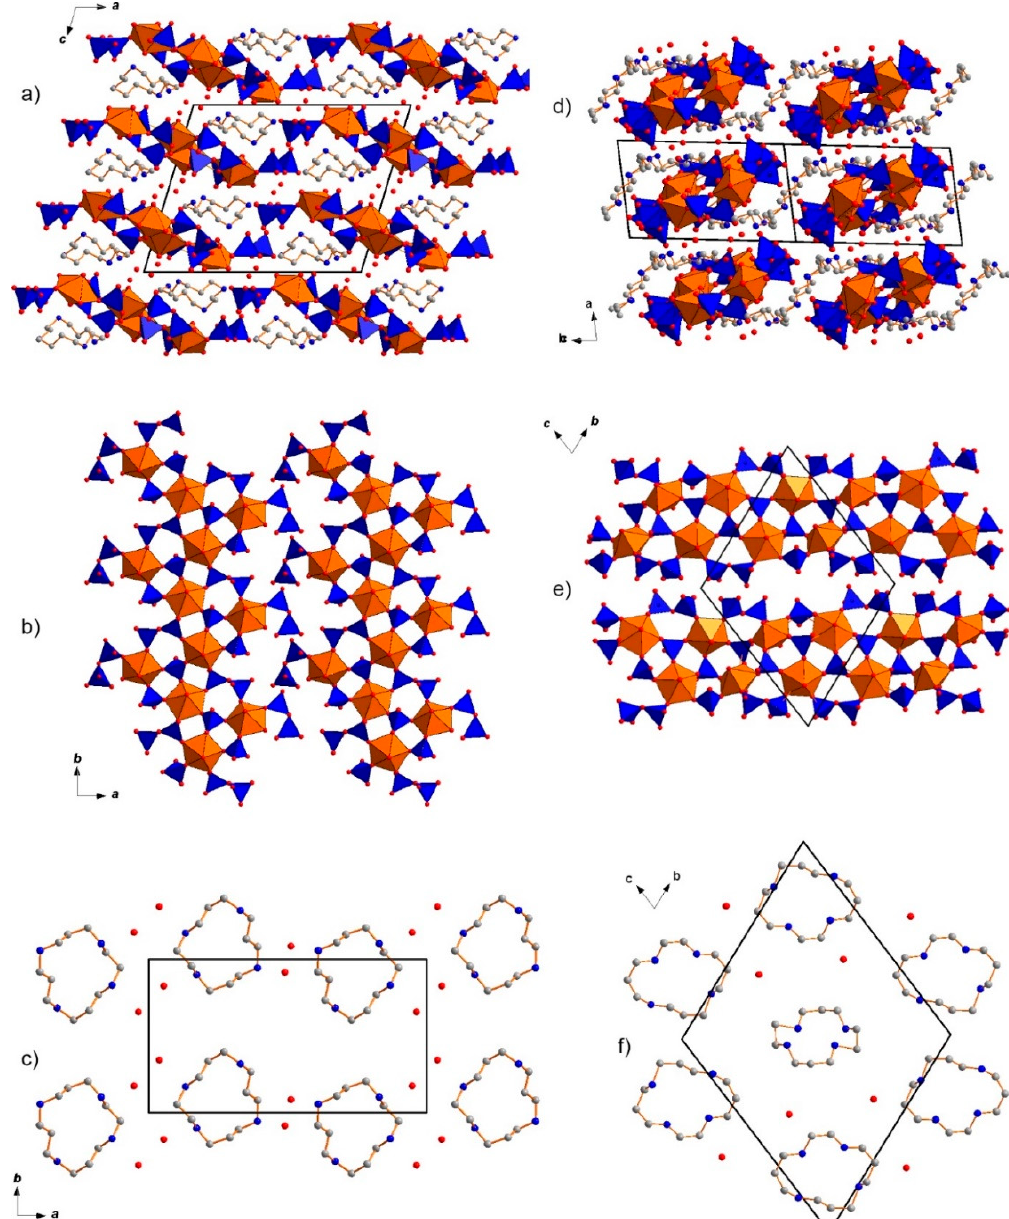
Figure 4. General projection of the structure of 2 (designations: UO 7 = orange; CrO 4 = blue) along the b -axis ( a ). Mutual arrangement of [(UO 2 ) 2 (CrO 4 ) 2 (Cr 2 O 7 ) 2 (H 2 O)] 4 − complex chromate-dichromate units projected along the c -axis ( b ); interlayer formed by [H 4 [15]aneN 4 ] 4+ cations and water molecules in 2 ( c ); general projection of the structure of 3 ( d ); pseudolayered arrangement of [(UO 2 ) 6 (CrO 4 ) 8 (Cr 2 O 7 ) 4 ] 12 − units projected along the a -axis ( e ); arrangement of water molecules, [H 4 Cyclam] 4+ and [H 4 [15]aneN 4 ] 4+ ions in the interlayer in 3 ( f ); hydrogen atoms are omitted for